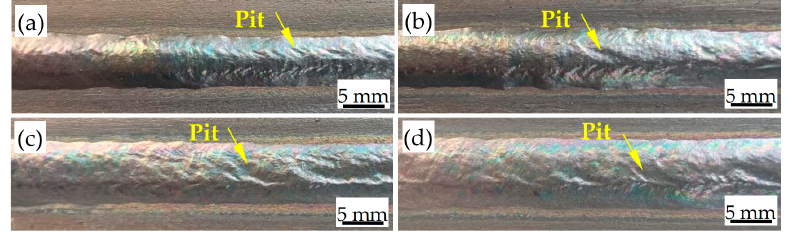
Figure 5. Surface morphology of laser–TIG hybrid welded joints with different currents: ( a ) I = 30 A; ( b ) I = 40 A; ( c ) I = 50 A; ( d ) I = 60 A.